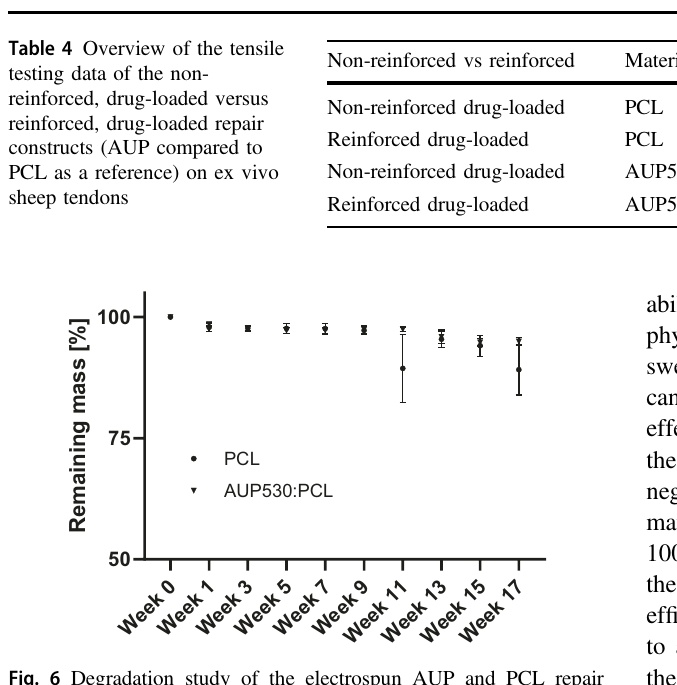
Fig. 6 Degradation study of the electrospun AUP and PCL repair constructs in aqueous